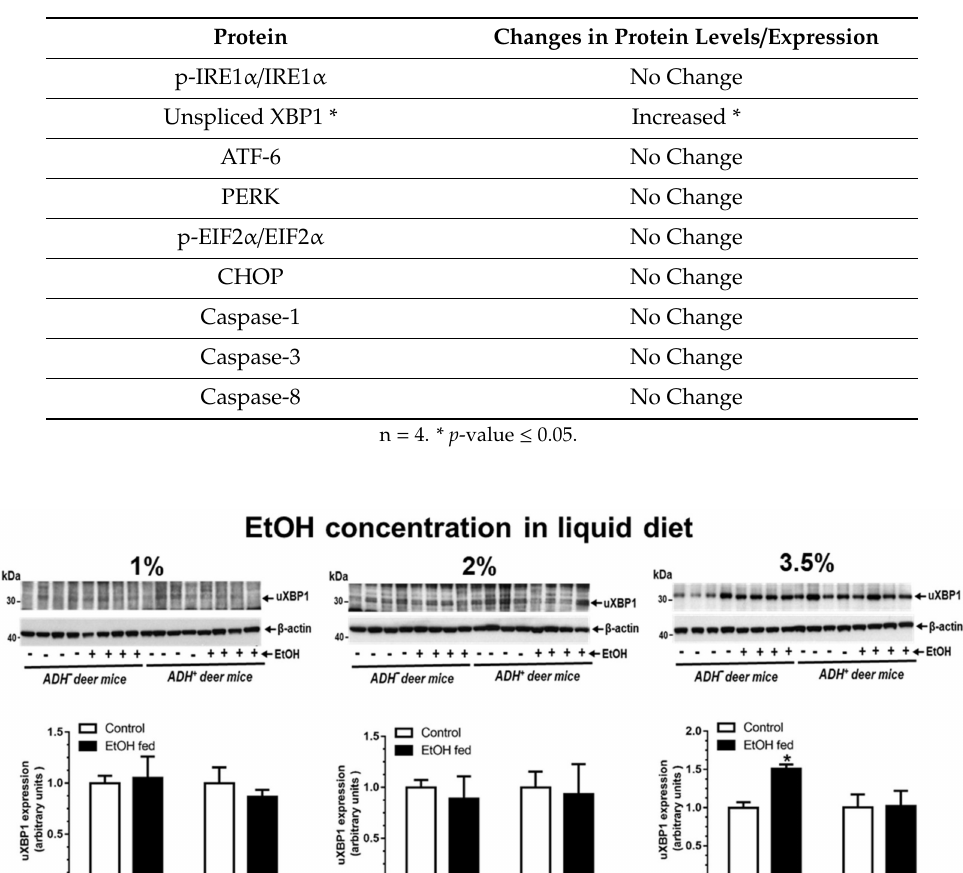
Table 1. Expression of proteins involved in ER stress and their responses, and cell death proteins in the livers of ADH − deer mice fed 3.5% EtOH compared to pair-fed controls